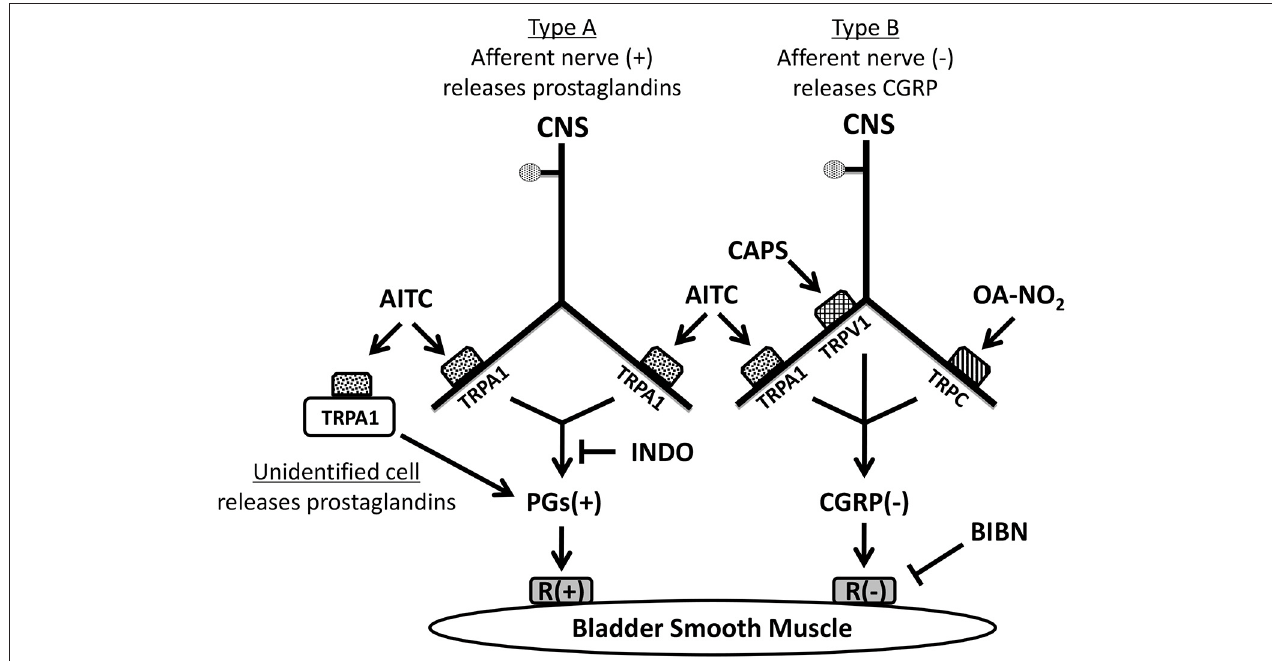
FIGURE 6 | Pharmacological experiments suggest that at least two types of sensory nerves expressing TRP channels innervate guinea pig urinary bladder. TRPA1 channels are located on one population of nerves (Type A). Activation of TRPA1 in these nerves and/or unidentified non-neuronal cells by AITC excites bladder smooth muscle; an effect blocked by indomethacin indicating that the excitation is mediated by the synthesis and release of prostaglandins (PGs). Another population of sensory nerves (Type B) expresses TRPV1, TRPA1, and TRPC channels. Activation of these channels by capsaicin (CAPS), AITC, or OA-NO 2 releases CGRP causing inhibition of the bladder smooth muscle. However, in comparison to the prominent effects of CAPS and OA-NO 2 the inhibitory effect of AITC mediated by CGRP release from Type B nerves is relatively weak and only detectable when prostaglandin (PG) synthesis is blocked by indomethacin indicating that it is normally masked by the PG excitation. ( + ): excitatory; (–):